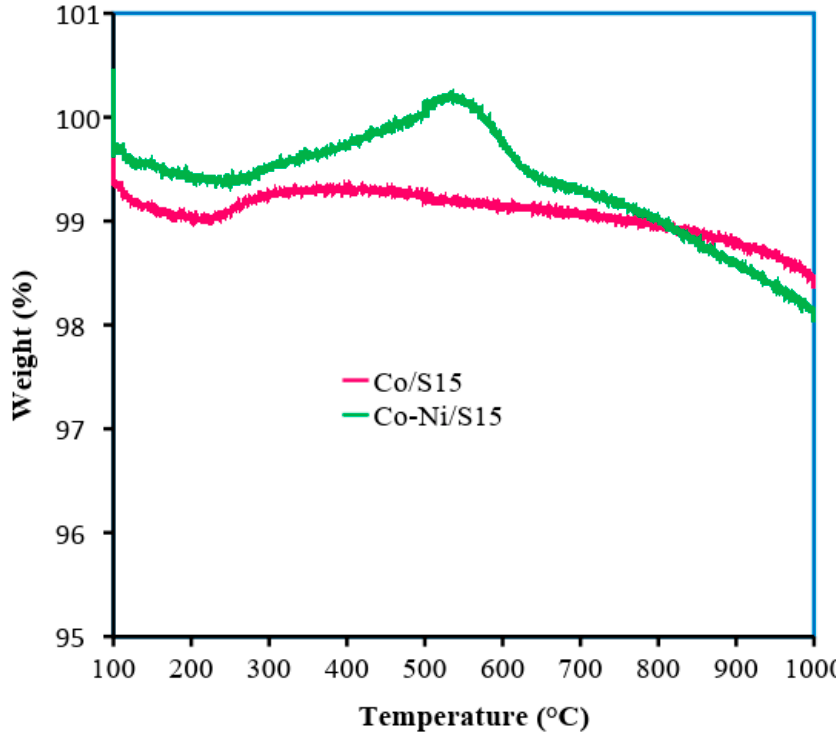
Figure 8. Weight change during the temperature-programmed oxidation (TPO) test as recorded by TGA for Co/S15 and Co–Ni/S15.